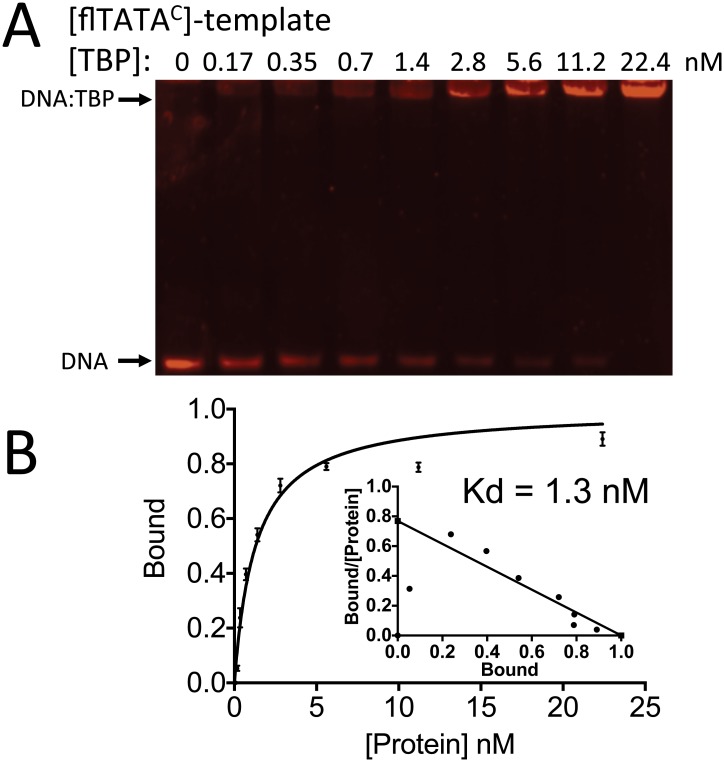
EMSA analysis of BbTBP binding to flTATAC oligonucleotide.(A) Gel shift on 6% non-denaturing PAGE using 0.1 nM fluorescent labeled TATAC-oligonucleotide and indicated concentrations of purified BbTBP (0–22.4 nM). (B) Quantification and analysis of BbTBP binding to flTATAC oligonucleotide. Data fit to Y = Bmax X/(Kd + X), resulting in a Kd = 1.3 ± 0.16 nM, Bmax = 1, R2 = 0.97.